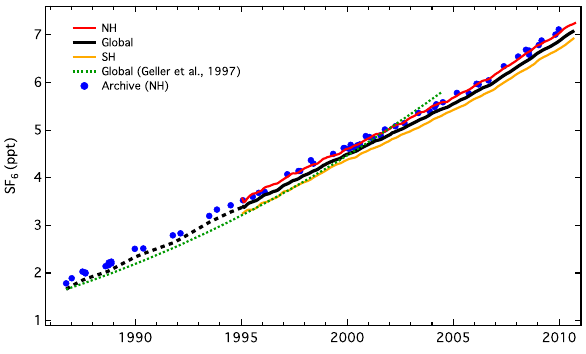
Fig. 7. Global and hemispheric mean SF 6 from flask and in situ data Figure 7: Global and hemispheric mean SF 6 from flask and in situ data along with NH archive 552 along with NH archive samples. The dashed line prior to 1995 rep- samples. The dashed line prior to 1995 represents the global mean derived from NH archive data 553 resents the global mean derived from NH archive data (computed (computed from a lowess fit to the NH archive record minus the mean difference (0.14 ppt) 554 from a lowess fit to the NH archive record minus the mean dif- between NWR and the global mean from 1995-2005). A linear fit of global mean SF 6 as a 555 ference (0.14ppt) between NWR and the global mean from 1995– function of time (t) from 1986-2005 yields: y = 1.25 (0.01) + 0.215 (0.001) * (t – 1985). 556 2005). A linear fit of global mean SF 6 as a function of time ( t ) from 557 1986–2005 yields: y = 1 . 25 ( 0 . 01 ) + 0 . 215 ( 0 . 001 ) × (t